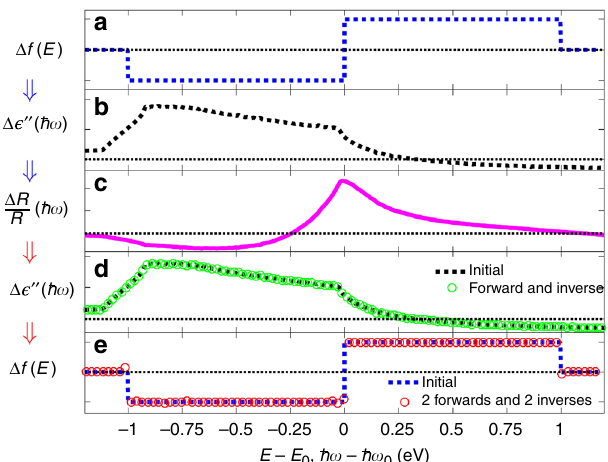
Fig. 2 Validation of the double inversion method. a A hypothetical change in the electron energy distribution, Δ f ( E ). b The corresponding Δ ϵ ′′ ( ħ ω ) due to Δ f ( E ). c The corresponding differential re fl ectivity, Δ R / R ( ħ ω ) inferred with the perturbed metallic dielectric function. In our procedure we take Δ R / R ( ħ ω ) and invert the relevant integral equations to obtain Δ ϵ ′′ ( ħ ω ), d , and Δ f ( E ), e . The latter agrees well with the original form, a . Note that in the upper and lower panels the x axis is E (eV), where zero refers to the Fermi level, while in the three middle panels the x axis is ħ ω , where zero refers to the gap between the d-band and the conduction band of the L- point, which is roughly 2.45